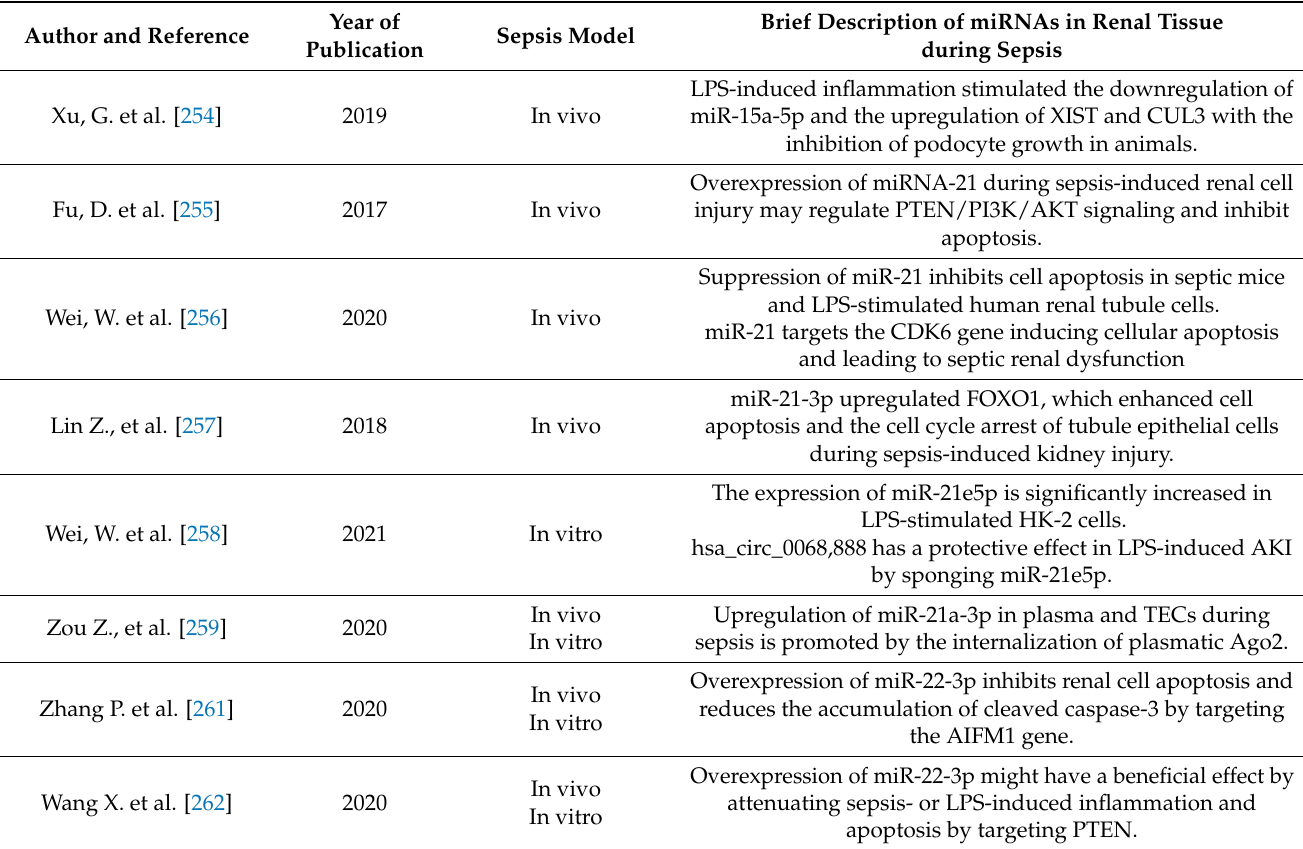
Table 6. miRNA expression in sepsis-related kidney